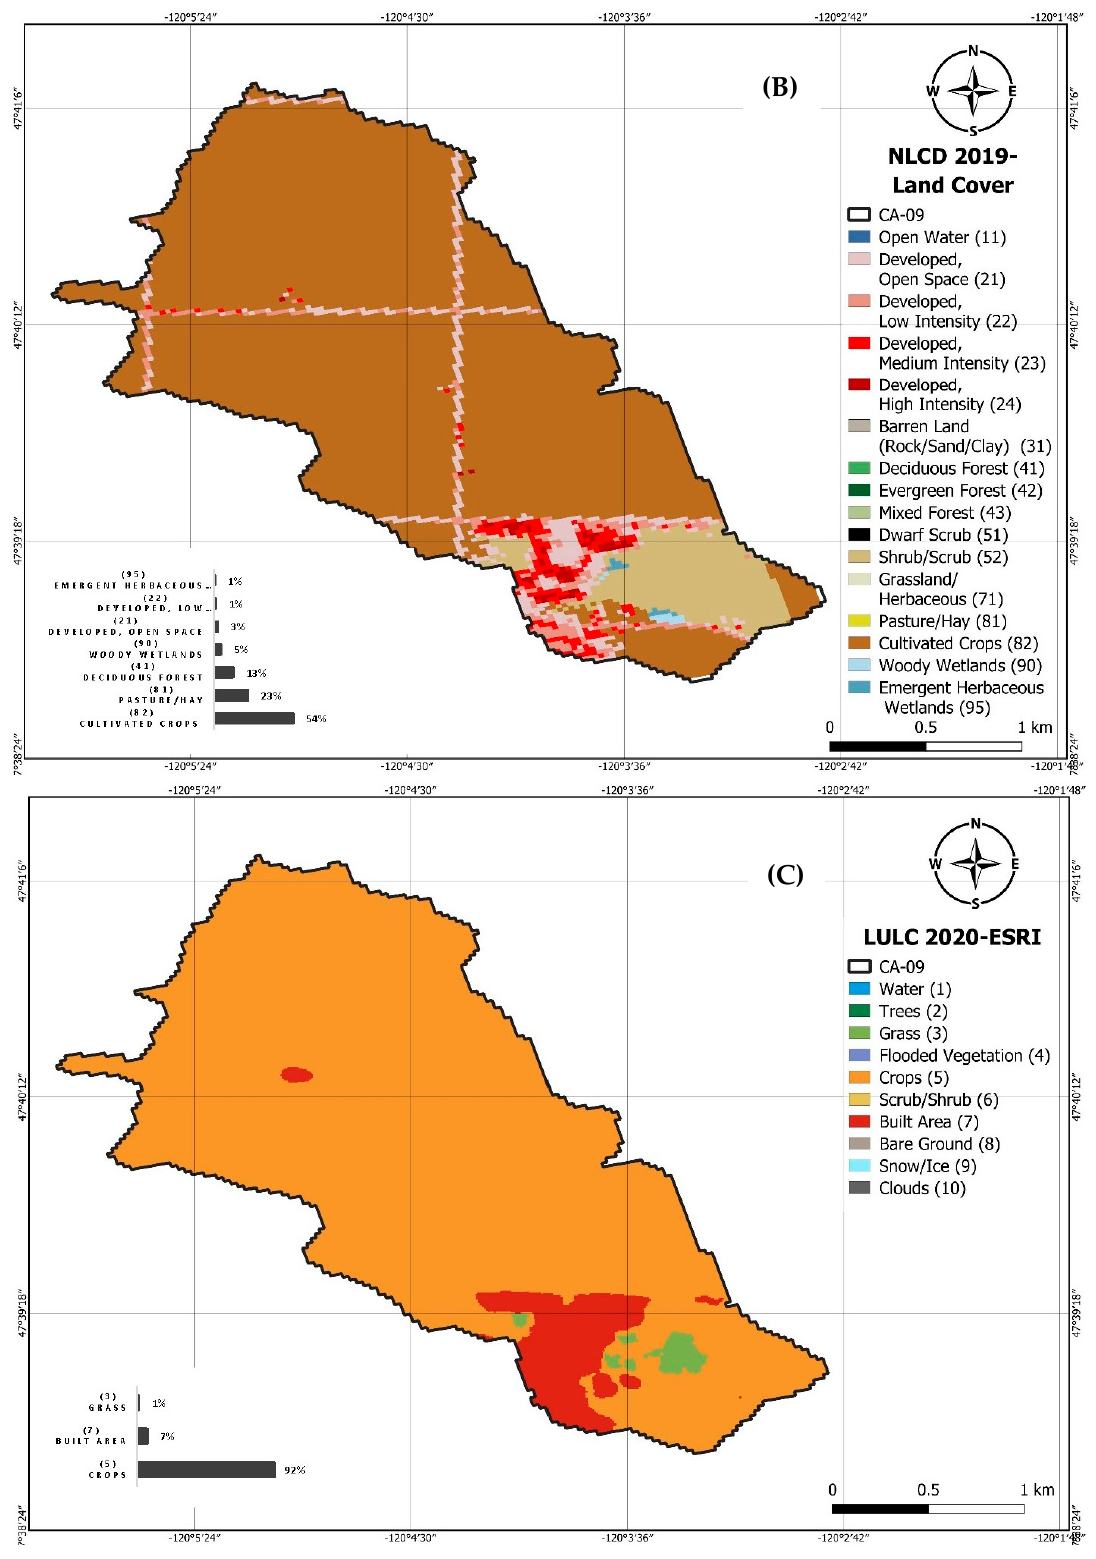
Figure A9. DEM and land-use maps for Catchment CA-09 ( A ) DEM, ( B ) NLCD 2019 land-use map, ( C ) LULC 2020-ESRI land-use map.